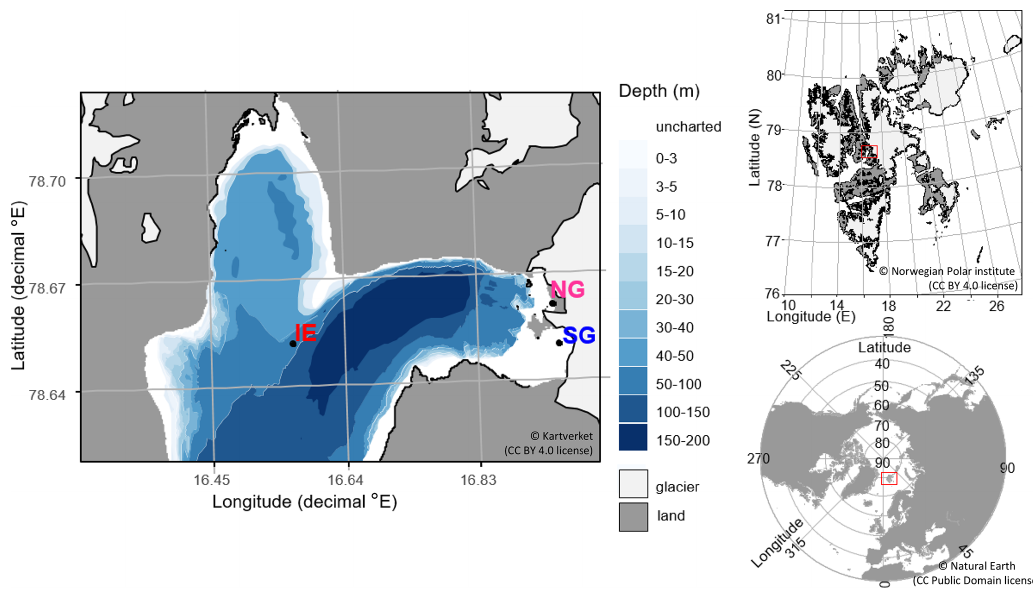
Figure 1. Sampling sites in Billefjorden: (a) detailed Billefjorden map showing the stations at the ice edge (IE), north glacier (NG), and south glacier (SG) on the underlying bathymetric map. White areas are uncharted with water depths of about 30m at NG and SG. The insets to the right show the location of (b) Billefjorden on a Svalbard map and (c) Svalbard on a pan-Arctic map, marked with red boxes. Land is shown as dark grey, ocean as white, and glaciers as light